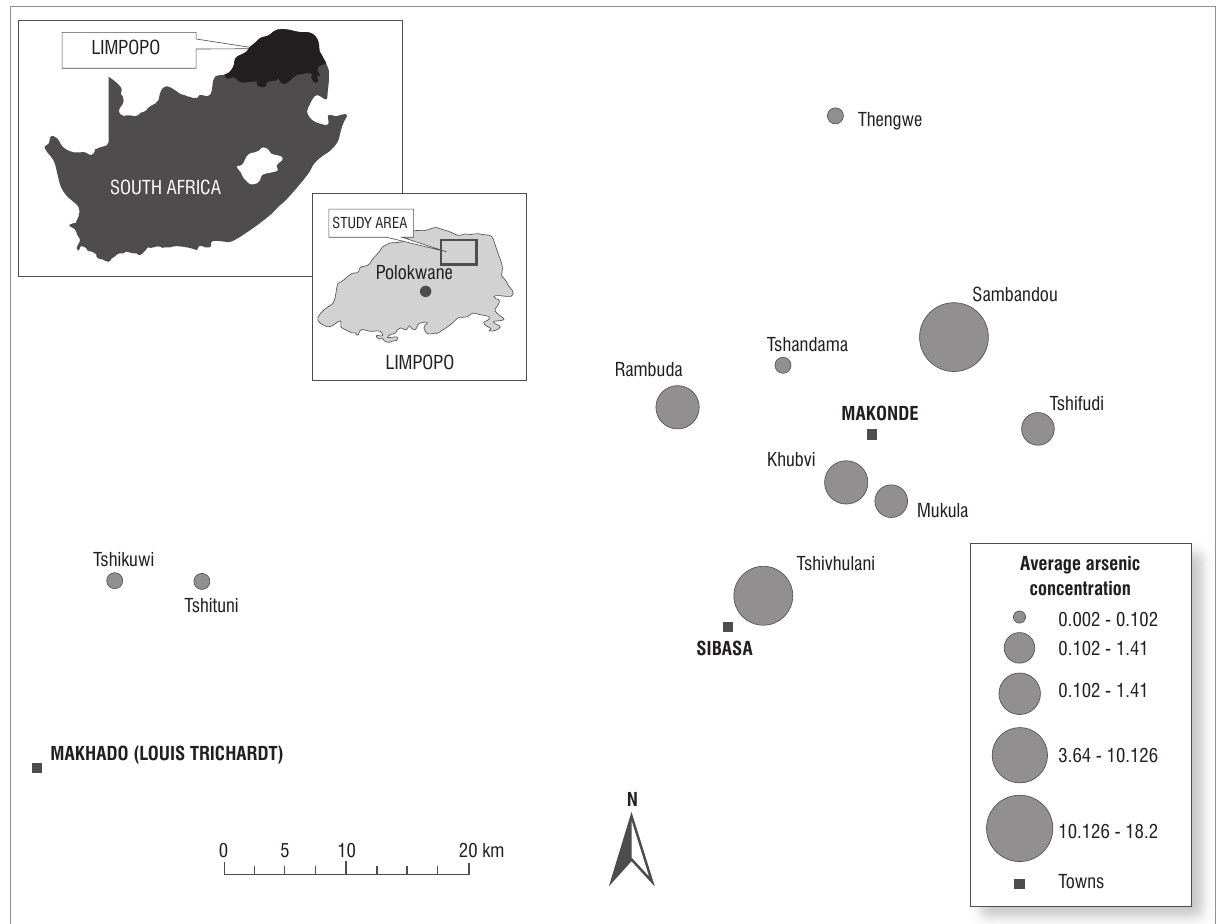
Figure 2: Average arsenic concentrations (mg/kg) in soil at 10 dip sites in the Vhembe district, Limpopo Province, South Africa.